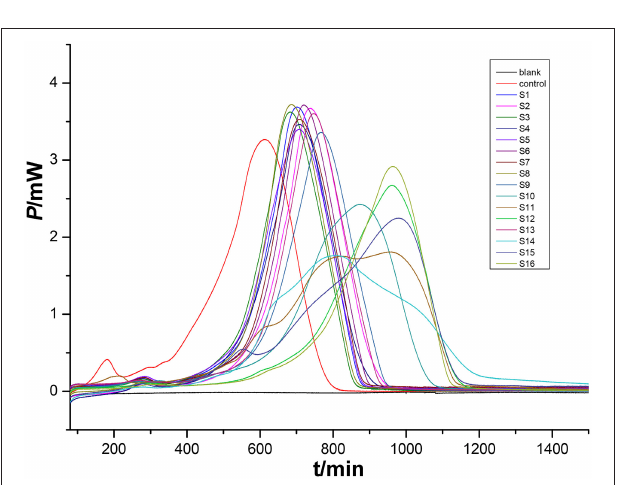
FIGURE 5 | HP-time curves of P. aeruginosa at 37 ◦ C in the presence of different batches of